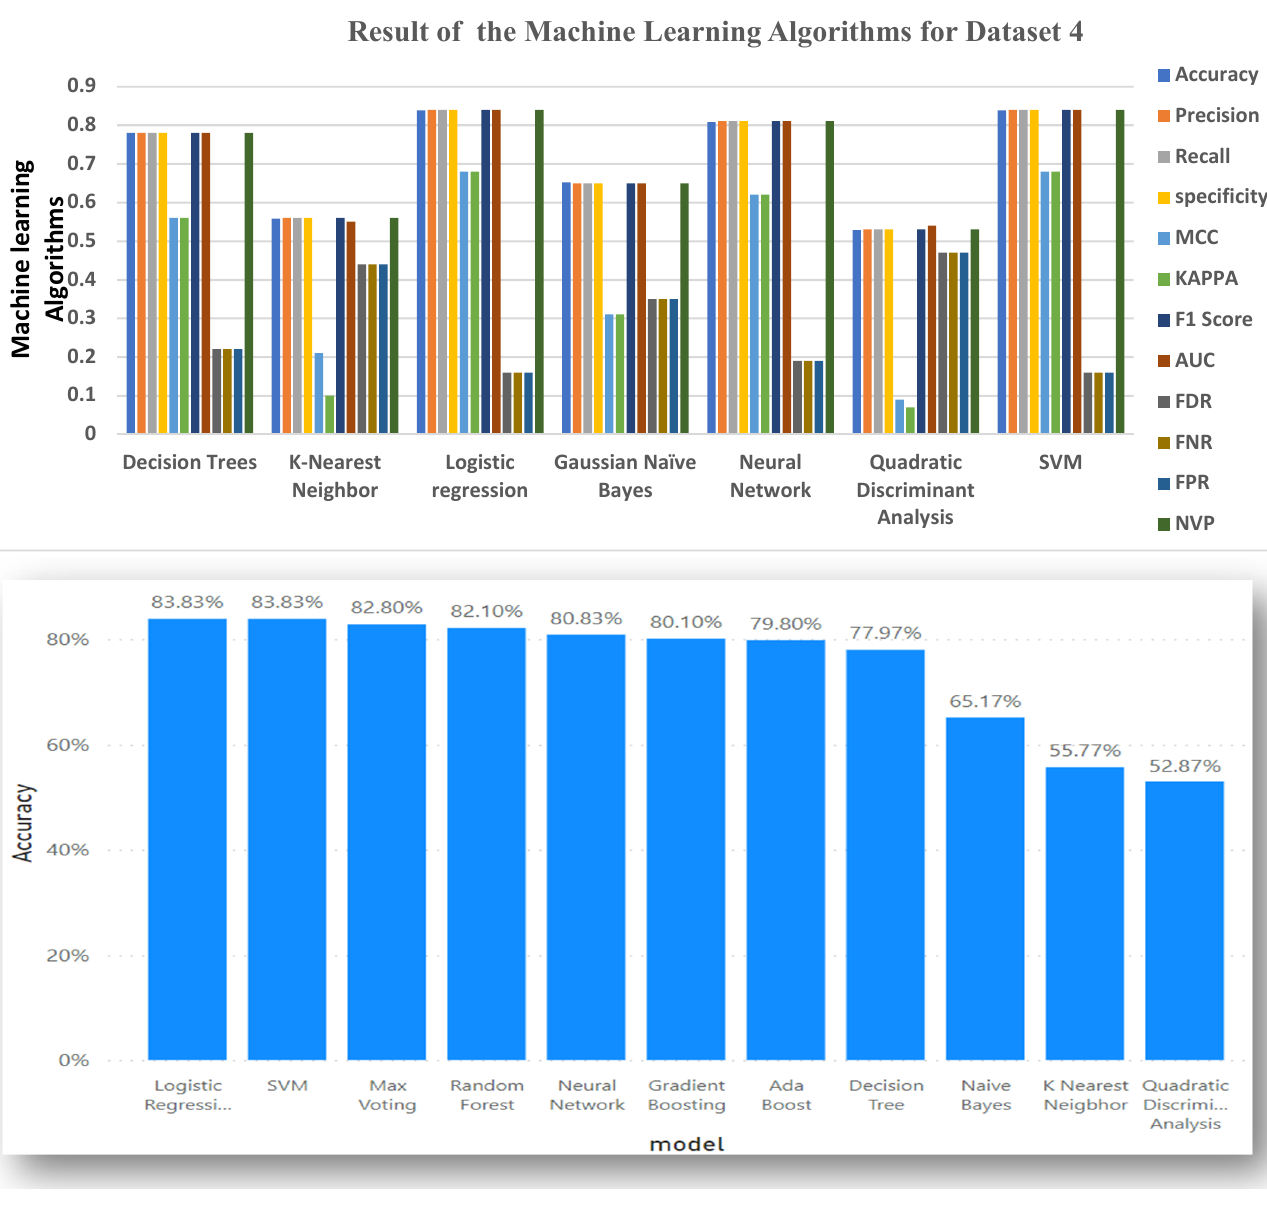
Figure 7. Graphical representations of Evaluation Metrics against Machine Learning Algorithms and ensemble learning for Dataset 4.